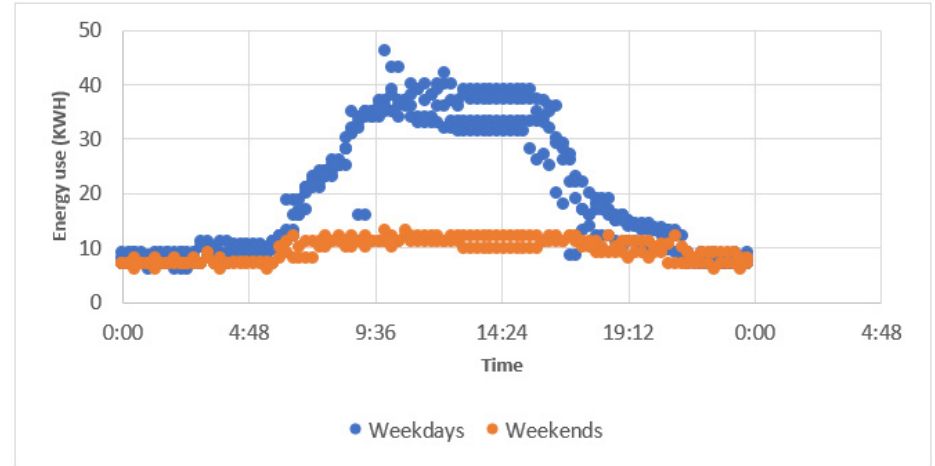
Figure 22. A comparison of a week’s weekday and weekend building energy use.